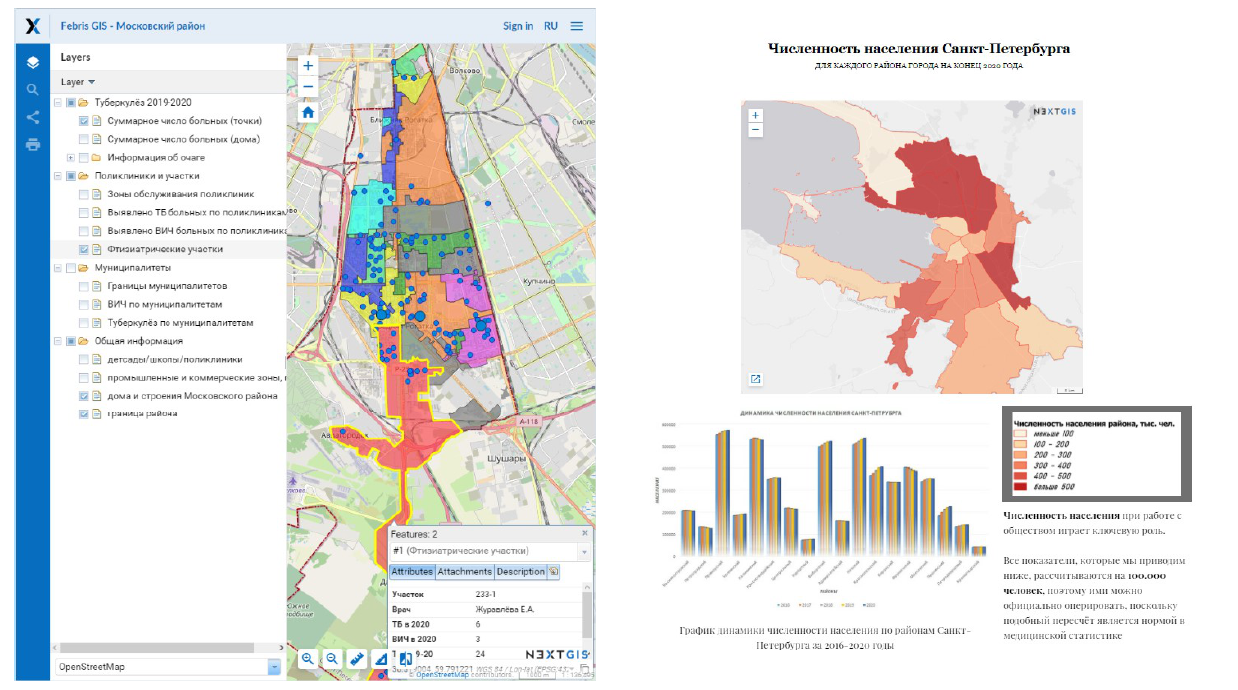
Figure 8 . NextGIS/FEBRIS GIS Web interface.